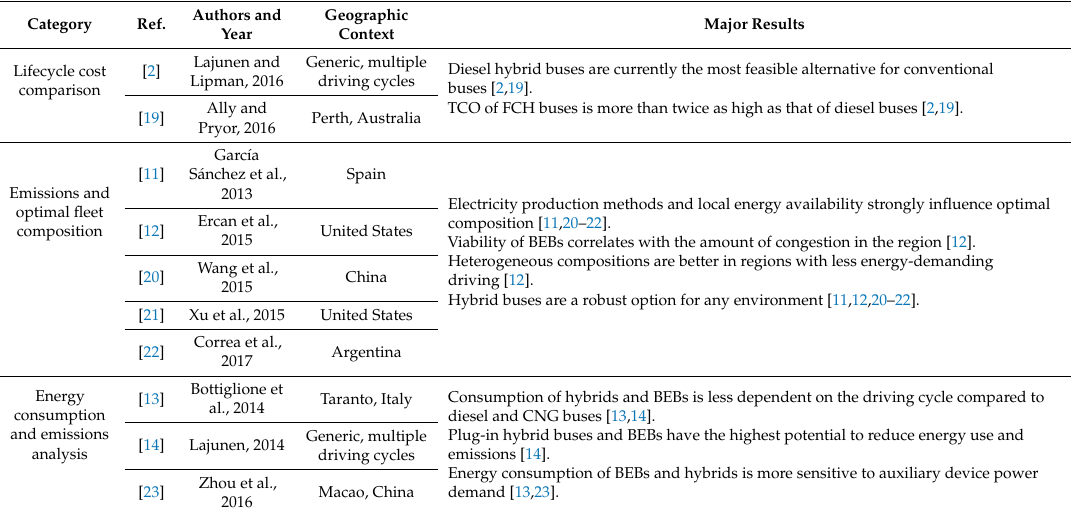
Table 1. Summary of literature